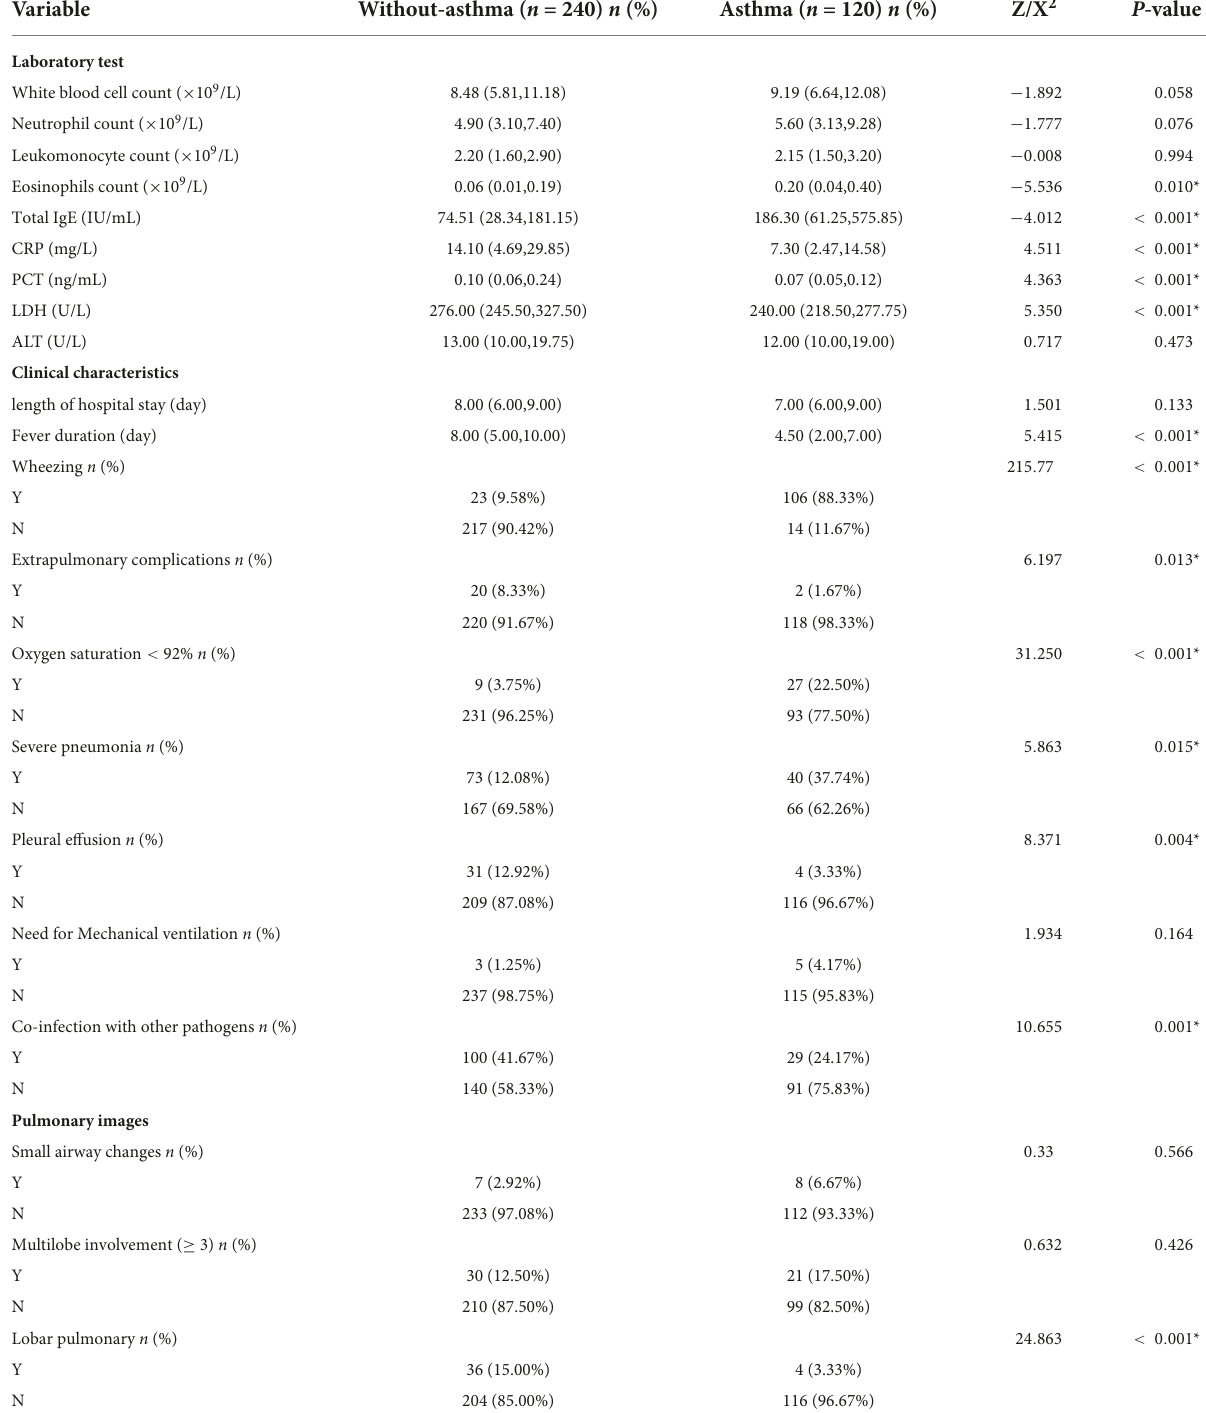
TABLE 2 Clinical characteristics of the children with MPP with and without